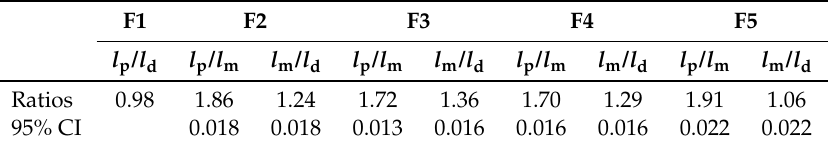
Table 2. Ratios of the functional lengths of the proximal ( l p ), middle ( l m ) and distal ( l d ) phalanges according to Hamilton et al. [40] (F2–F5), Buchholz et al. and Buryanov et al. [39,42] (F1). The 95% confidence intervals (CI) observed by [40] are also included.